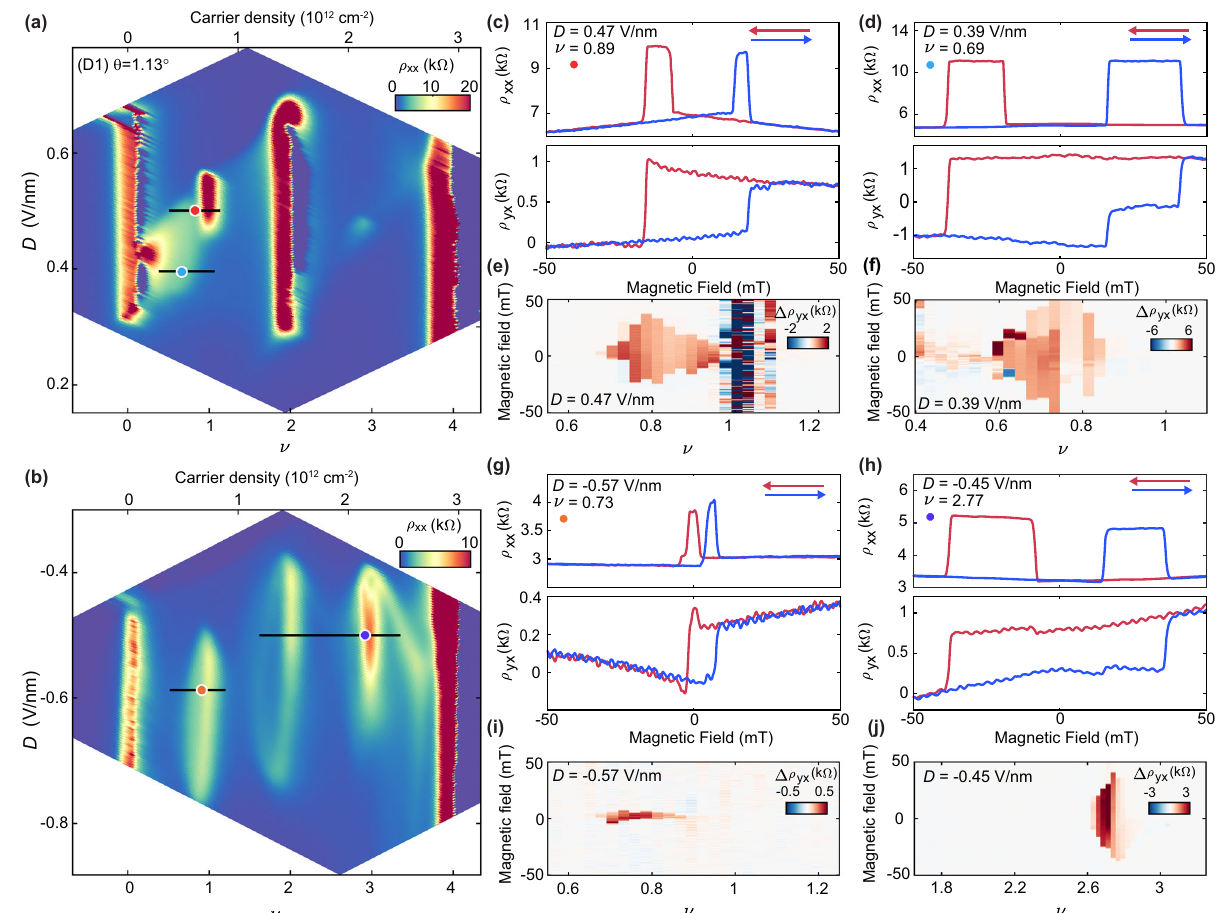
Fig. 1 AHE in metallic states of tMBG. a , b Longitudinal resistivity, ρ xx , of device D1 ( θ = 1.13 ∘ ) for D > 0 ( a ) and D < 0 ( b ). ρ xx is symmetrized at ∣ B ∣ = 0.5 T in order to suppress any magnetic hysteresis effects but looks very similar at B = 0 (Supplementary Fig. 3a). c , d ρ xx (top) and ρ yx (bottom) acquired as B is swept back and forth at ν and D indicated by the labels, and by the red and blue markers in ( a ), respectively. e , f Hysteresis loop height, Δ ρ yx , as a function of doping at D = 0.47V/nm ( e ) and D = 0.39 V/nm ( f ), as indicated by the black lines in ( a ). Rapidly oscillating red and blue points near ν = 1 in ( e ) arise due to the correlated trivial insulating state rather than magnetic ordering (see Supplementary Fig. 8a, b). g , h ρ xx (top) and ρ yx (bottom) acquired as B is swept back and forth at ν and D indicated by the labels, and by the orange and purple markers in ( b ), respectively. i , j Δ ρ yx as a function of doping at D = − 0.57 V/nm ( i ) and D = − 0.45 V/nm ( j ), as indicated by the black lines in ( b ). We note that small oscillation features in ρ yx curves are noise, arising due to the low excitation current (1 nA) used in the measurements. ρ yx is not antisymmetrized and is offset from zero as a result of mixing with ρ xx . All data are acquired at T = 0.3